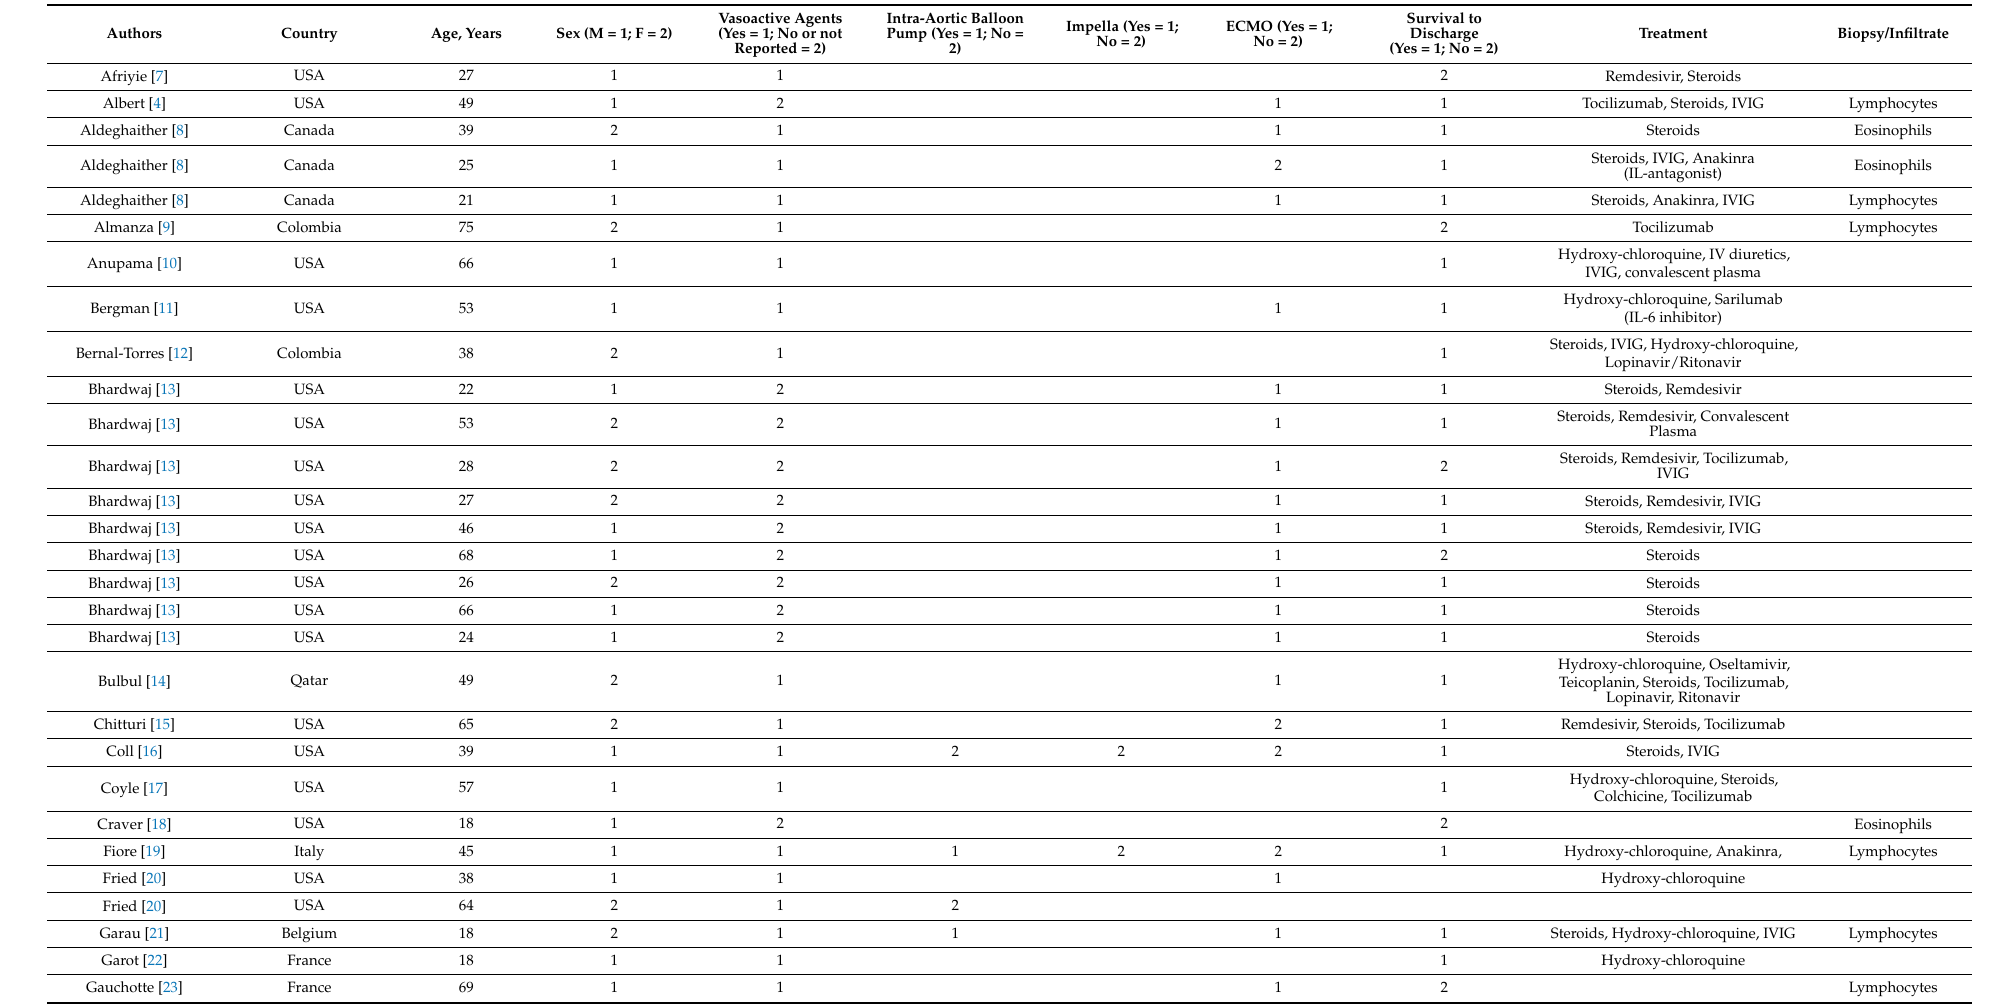
Table 1. Cases of COVID-19 fulminant